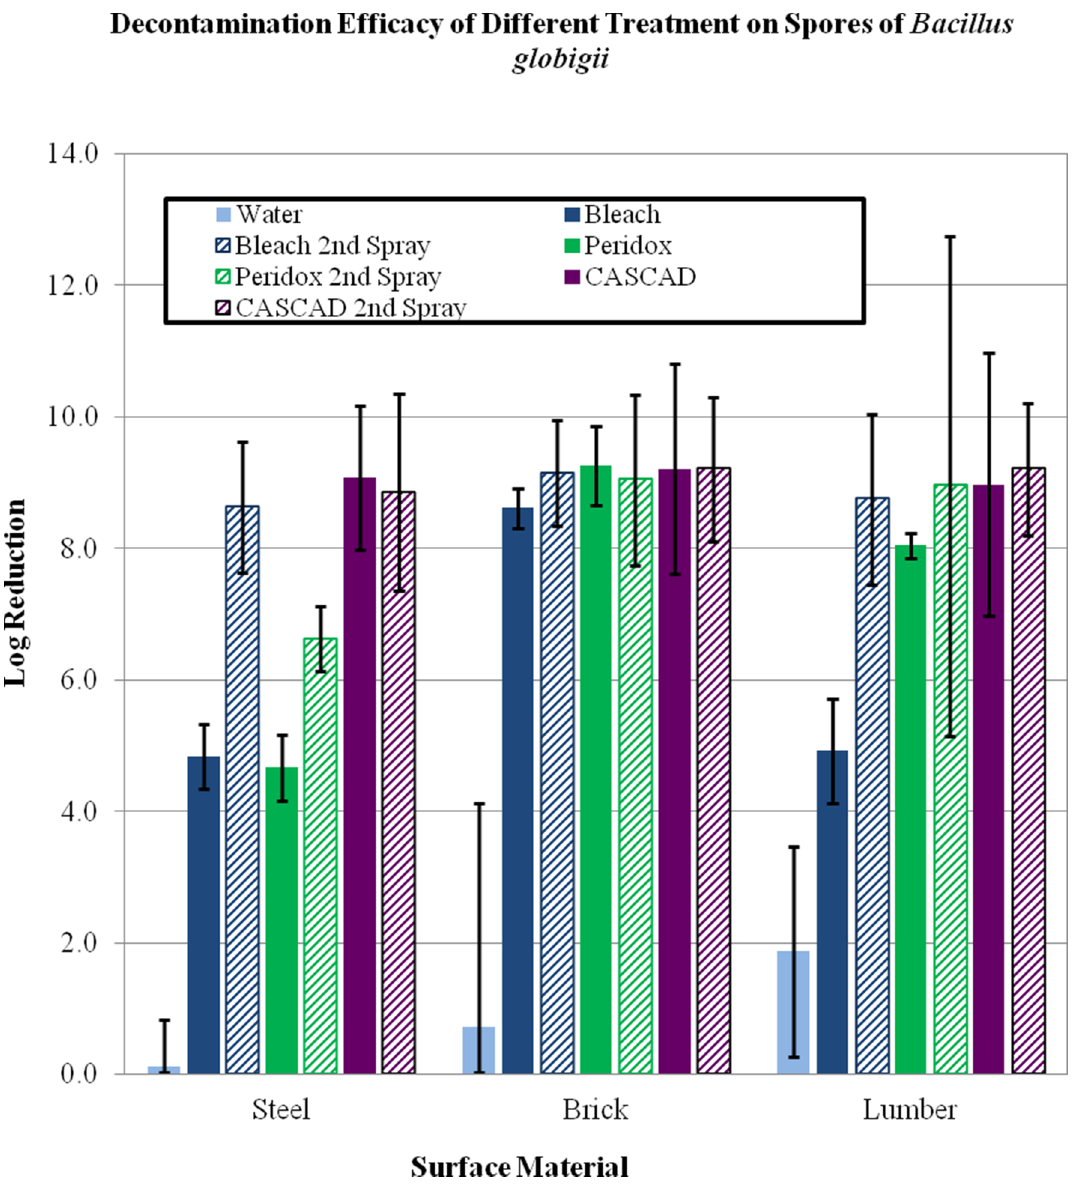
Figure 3. Sporicidal efficacy of three COTS disinfectants. doi:10.1371/journal.pone.0099827.g003 PLOS ONE |